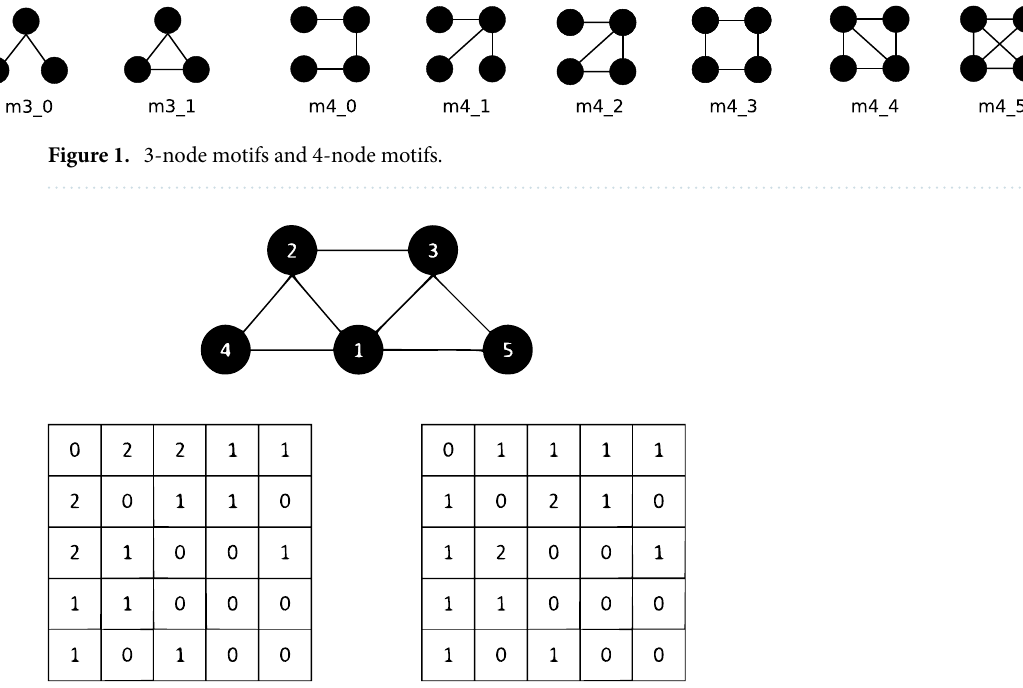
Figure 2. The motif co-occurrence matrix is constructed according to the specific motif m t